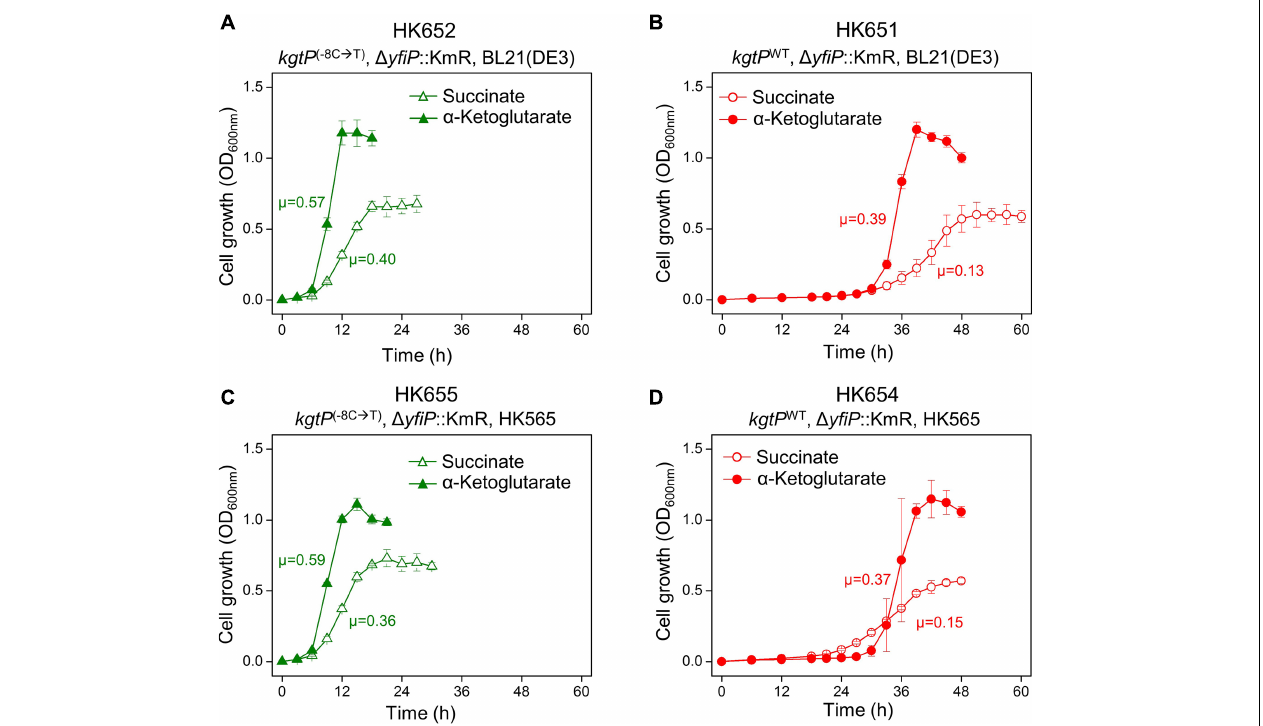
FIGURE 4 | Effect of the – 8C-to-T single point mutation at the promoter of the kgtP gene on cellular growth in M9 minimal medium containing succinate or α -ketoglutarate. (A) kgtP ( − 8C → T ) /BL21(DE3), (B) kgtP WT /BL21(DE3), (C) kgtP ( − 8C → T ) /HK565, and (D) kgtP WT /HK565. kgtP ( - 8C → T ) and kgtP WT were transferred via P1 phage transduction to generate mutant cells from BL21(DE3) and revertant cells from the HK565 strain, respectively. The unit of specific growth rate ( µ ) is h - 1